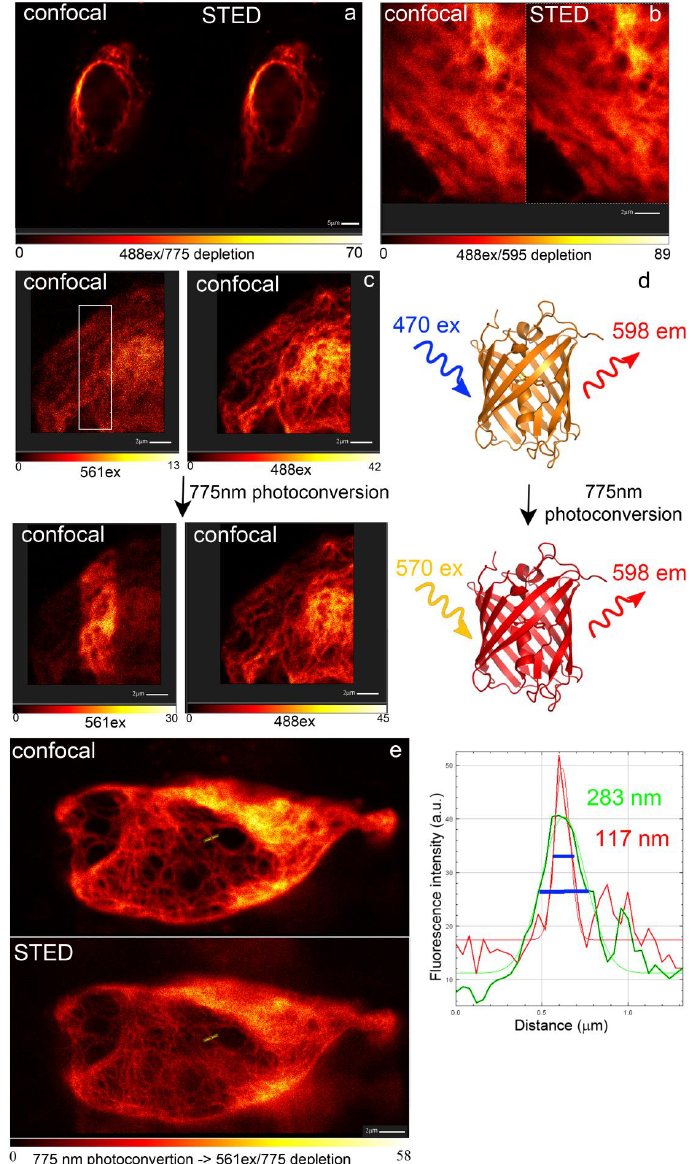
Figure 11. STED imaging of vimentin-LSSmScarlet fusion in HeLa cells. ( a ) Confocal and STED images of fixed cells expressing vimentin-LSSmScarlet. STED settings: 488 nm excitation—3.17% laser power; 775 nm STED—2% laser power; STED gated on delay 750 ps, width 8 ns; emission range of 560–725 nm; pixel dwell time—4 µ s in 9 repetitions. ( b ) Confocal and STED images of fixed cells expressing vimentin-LSSmScarlet. STED settings: 488 nm excitation—5% laser power; 595 nm STED— 100% laser power; on delay 750 ps, width 8 ns; emission range of 560–585 nm; dwell time—12 µ s; line steps—4 repetitions, 16 total lines. ( c ) Confocal images of fixed cells expressing vimentin-LSSmScarlet before and after photoconversion with 775 nm depletion laser (50% power) in the region shown as a white box. ( d ) Schematic representation of excitation maxima of the LSSmScarlet protein as a consequence of the photoconversion with 775 nm light. ( e ) Confocal and STED images of live cells expressing vimentin-LSSmScarlet. The line profile for the marked area shows filament with 2.4-fold improvement of resolution. Line profile was fitted with y = a + (b − a) × exp( − (x − c) × (x − c)/2 × d × d)) equation. STED settings: 561 nm excitation—10.57% laser power; 775 nm STED—15% laser power; on delay 750 ps, width 8 ns; emission range of 570–765 nm; dwelltime—105 us; line steps—10 repetitions, 40 total